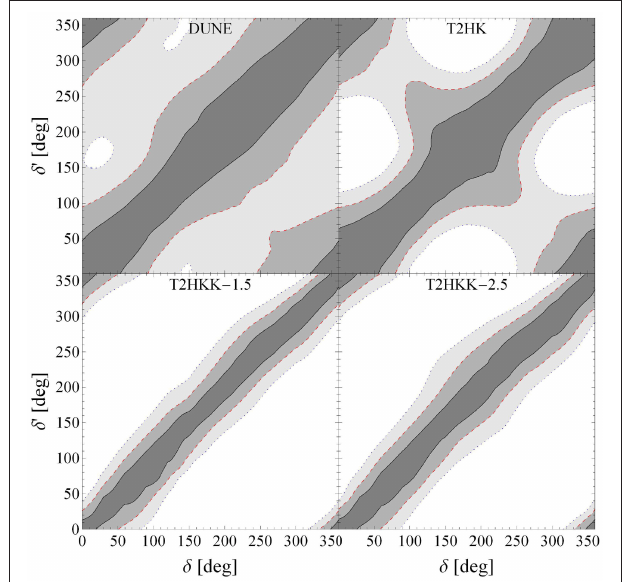
FIGURE 14 | The same as Figure 13 except that the mass ordering is assumed to be known. This plot is taken from Liao et al. [ 221], published under the terms of the Creative Commons Attribution Noncommercial License and therefore no copyright permissions were required for its inclusion in